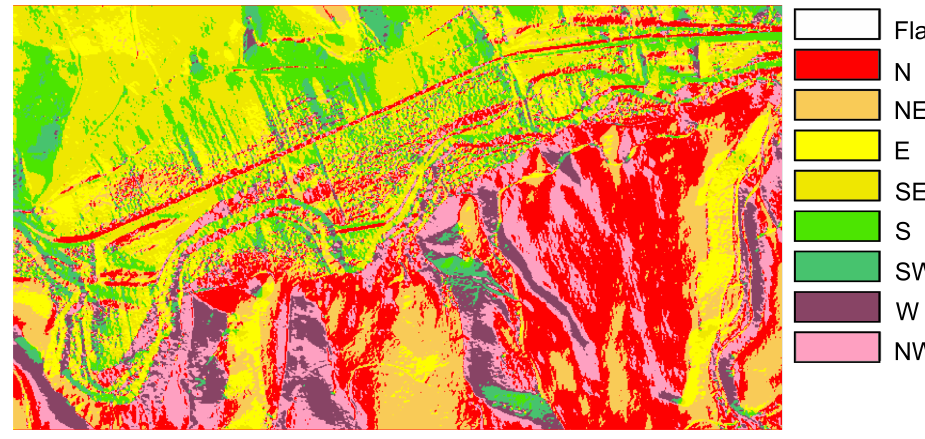
Figure 7. Classification of aspect (example in the sub-area shown in Figure